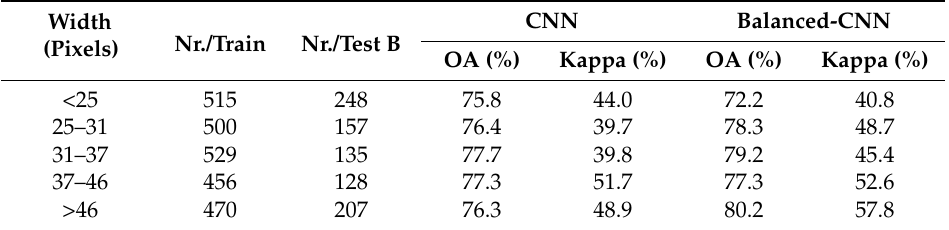
Table 5. SqueezeNet model performance on test B data re-classified by the number of building width